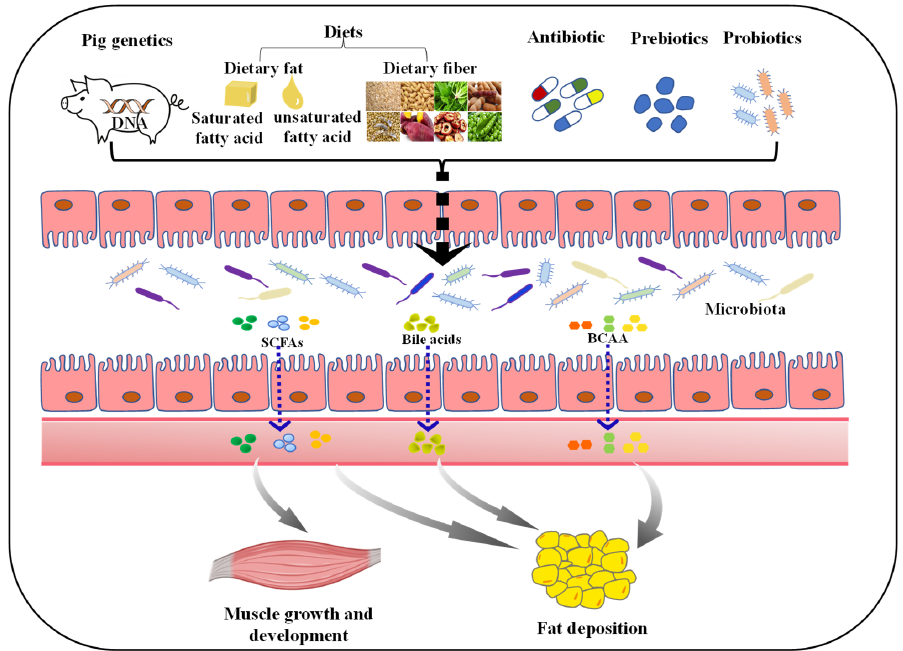
Figure 2. Factors affecting porcine muscle growth and development, and fat deposition via regulat-